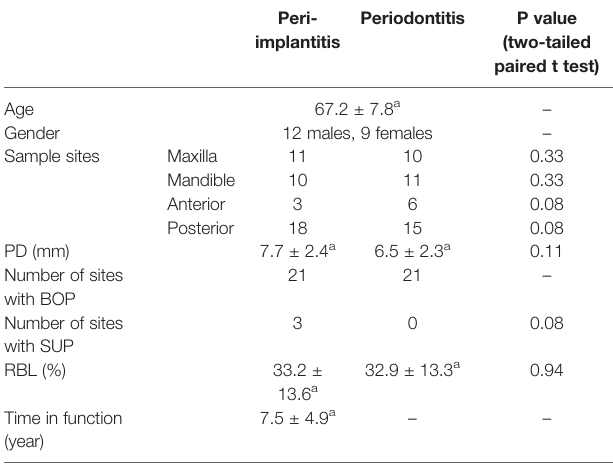
TABLE 1 | Clinical characteristics of the study